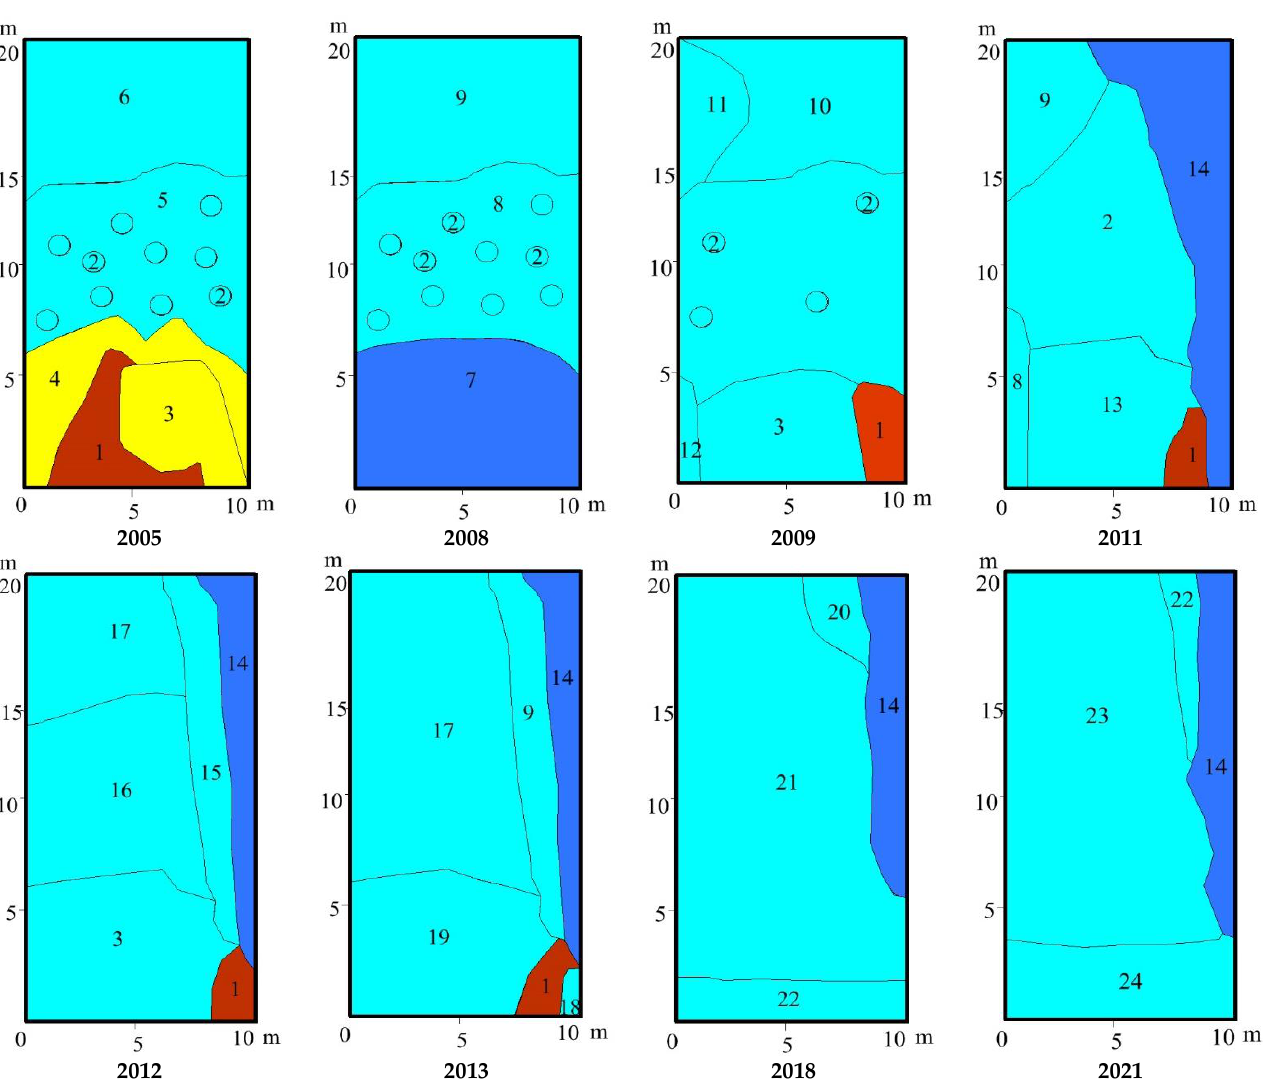
Figure 18. Changes in vegetation on permanent plot No. 4: 1 bare peat; 2 Eriophorum vaginatum ;